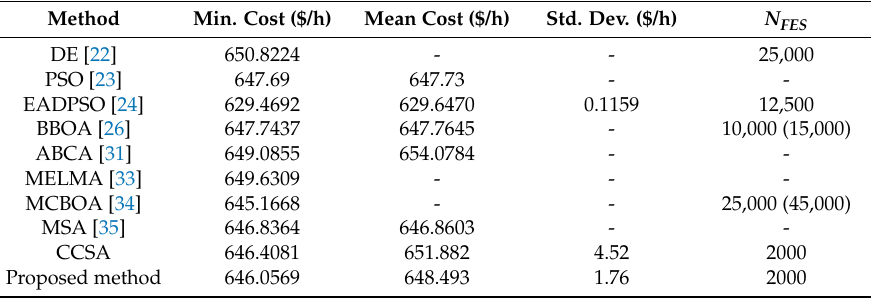
Table 8. The result comparison for subcase 3.3.